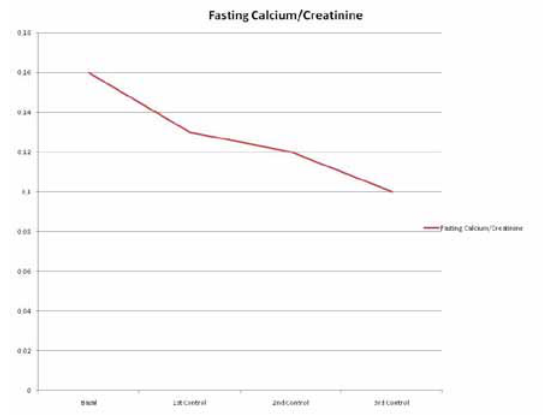
Figure 3. Evolution of urinary fasting calcium/creatinine after 3 years of treatment with